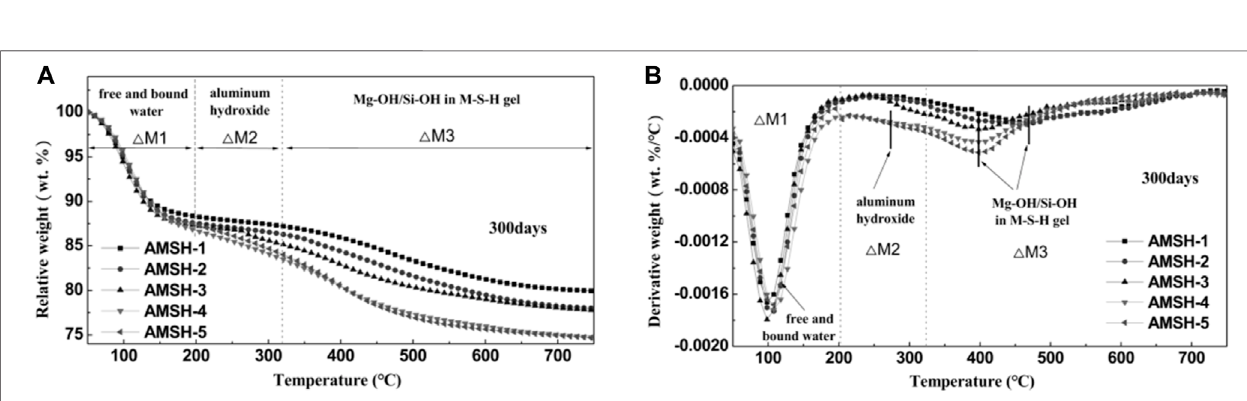
Frontiers in Materials |